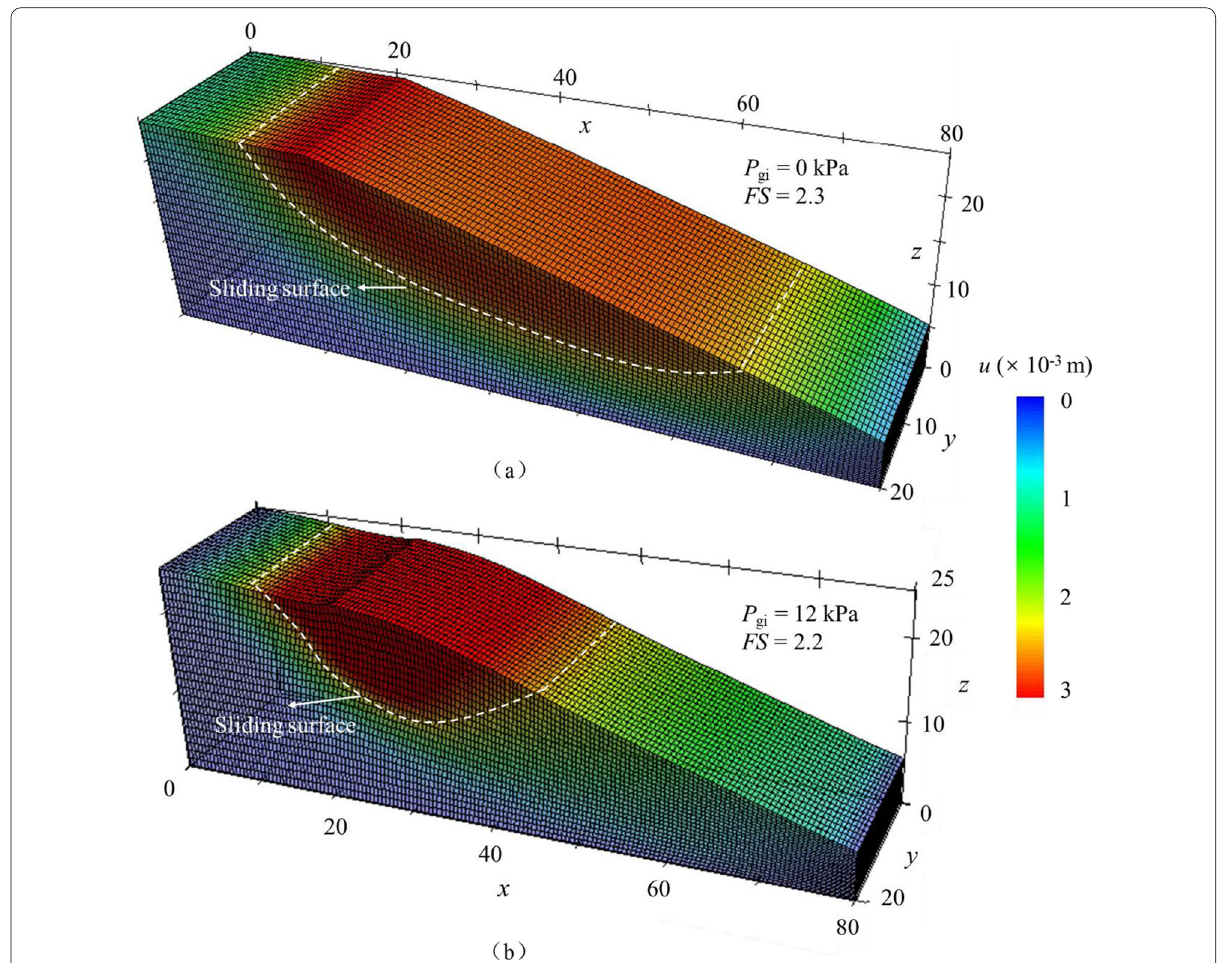
Fig. 9 Possible slope failure mode in terms of the displacement at an unstable state: a P gi